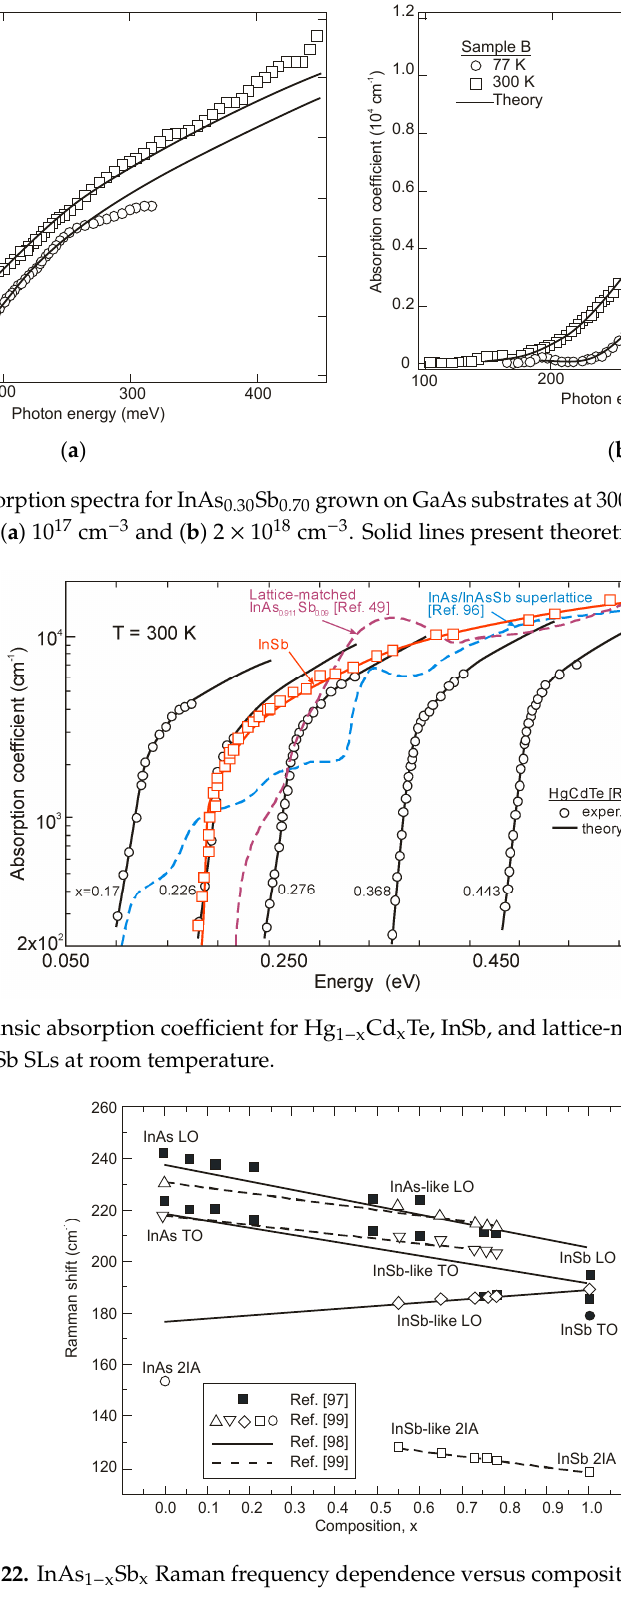
Figure 22. InAs 1 − x Sb x Raman frequency dependence versus composition (after [99]).